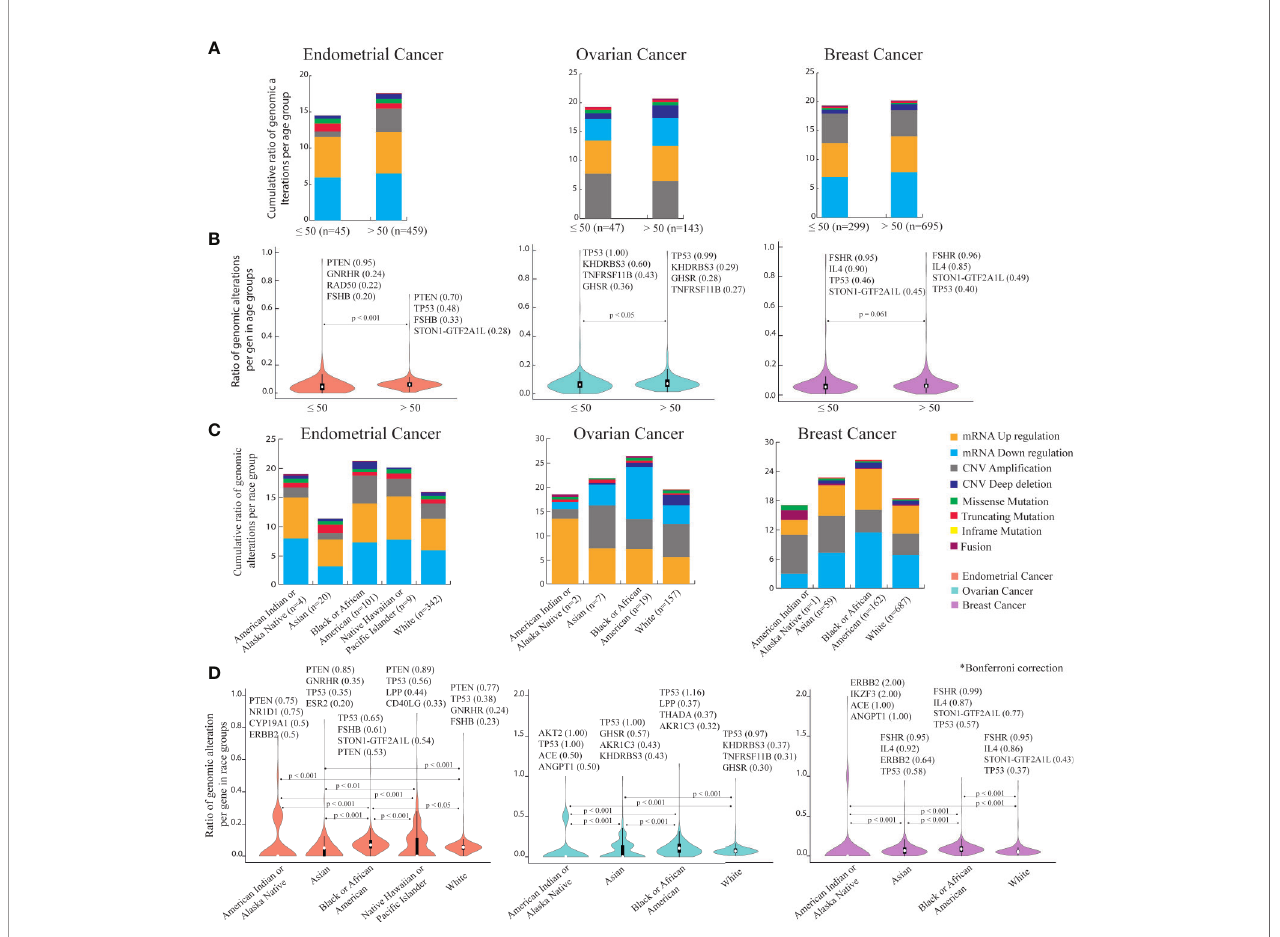
FIGURE 3 | Genomic alterations based on age and race categories in endometrial, ovarian and breast cancer using PanCancer Atlas data in cBioPortal. (A) Cumulative ratio of genomic alterations in women aged 50 or less and older than 50 years, per cancer type. (B) Ranking of genes with the highest number of genomic mutations per age group in each cancer type. Mann-Whitney U test with signi fi cant level of p < 0.05. (C) Cumulative ratio of genomic alterations per race category in three cancer types. (D) Ranking of genes with the highest number of genomic mutations per race group in the three cancer types. Dunn-Bonferroni post hoc method was performed following a signi fi cant Kruskal-Wallis test, only signi fi cant p-values are